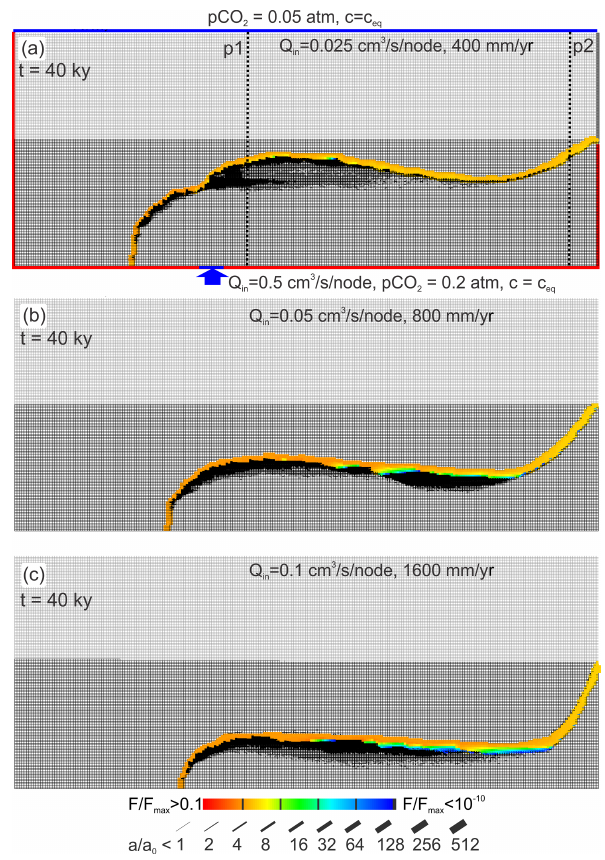
Figure 6. Cave pattern after 40000 years for various recharge rates Q : (a) 400mmyr − 1 , (b) 800mmyr − 1 , and (c) 1600mmyr − 1 and constant recharge from below. With increasing recharge, the flow domain of meteoric water increases, and the fringe of mix- ing is shifted downwards. To show that even low p CO upwelling water creates substantial karstification, we have used = 0 . 2atm. Everything else as in the standard scenario. p CO 2